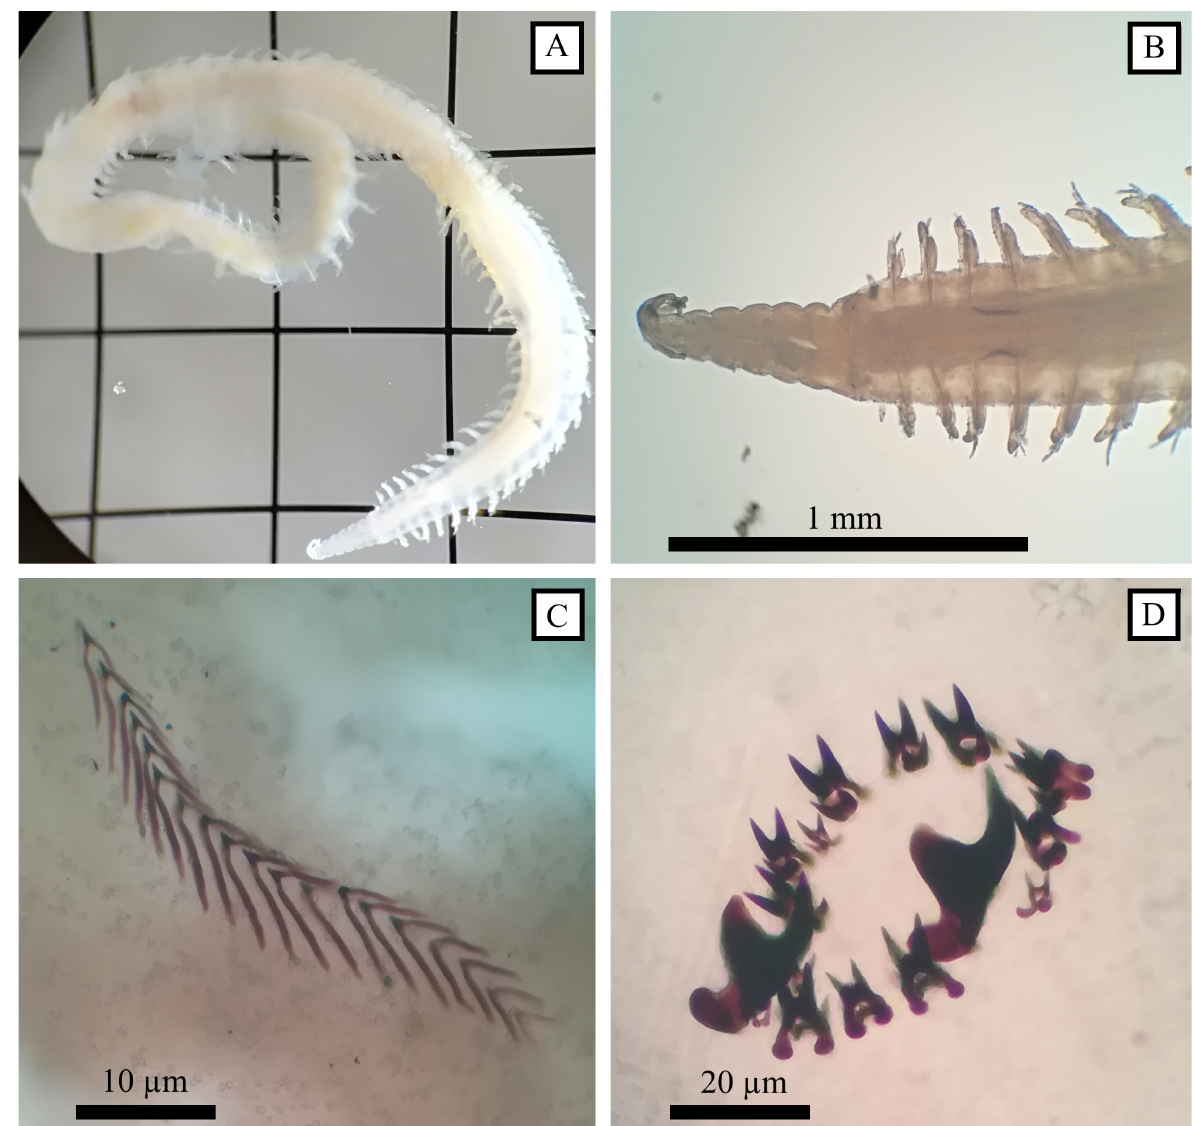
Figure 2. Goniadella bobrezkii. A. Dorsal view of whole animal. B. Dorsal view of anterior region. C. Chevrons. D. Rings of macrognaths and